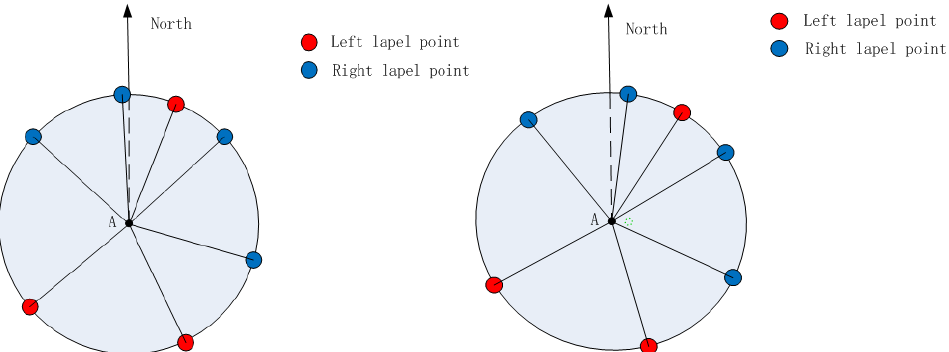
Figure 17. The influence of the position of an observation point on the sequence of lapel points: ( left ) Point A is the current observation point; and ( right ) the lapel point sequence as observed from a slightly moved A . The dotted circle represents the original position of A .